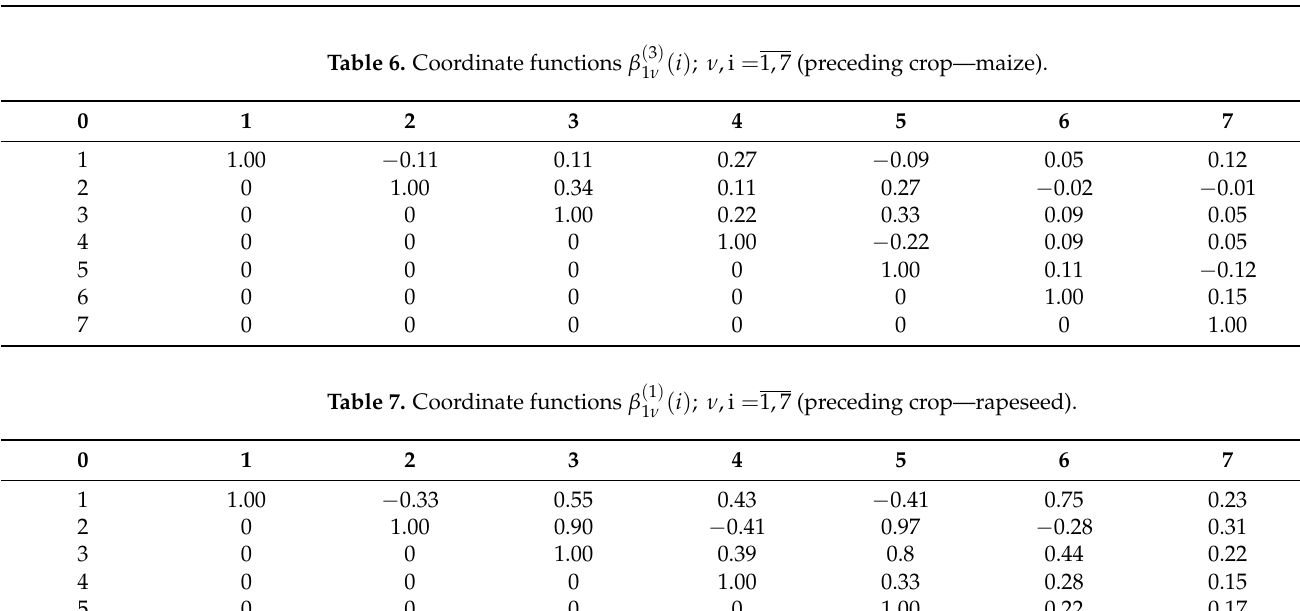
Table 6. Coordinate functions β